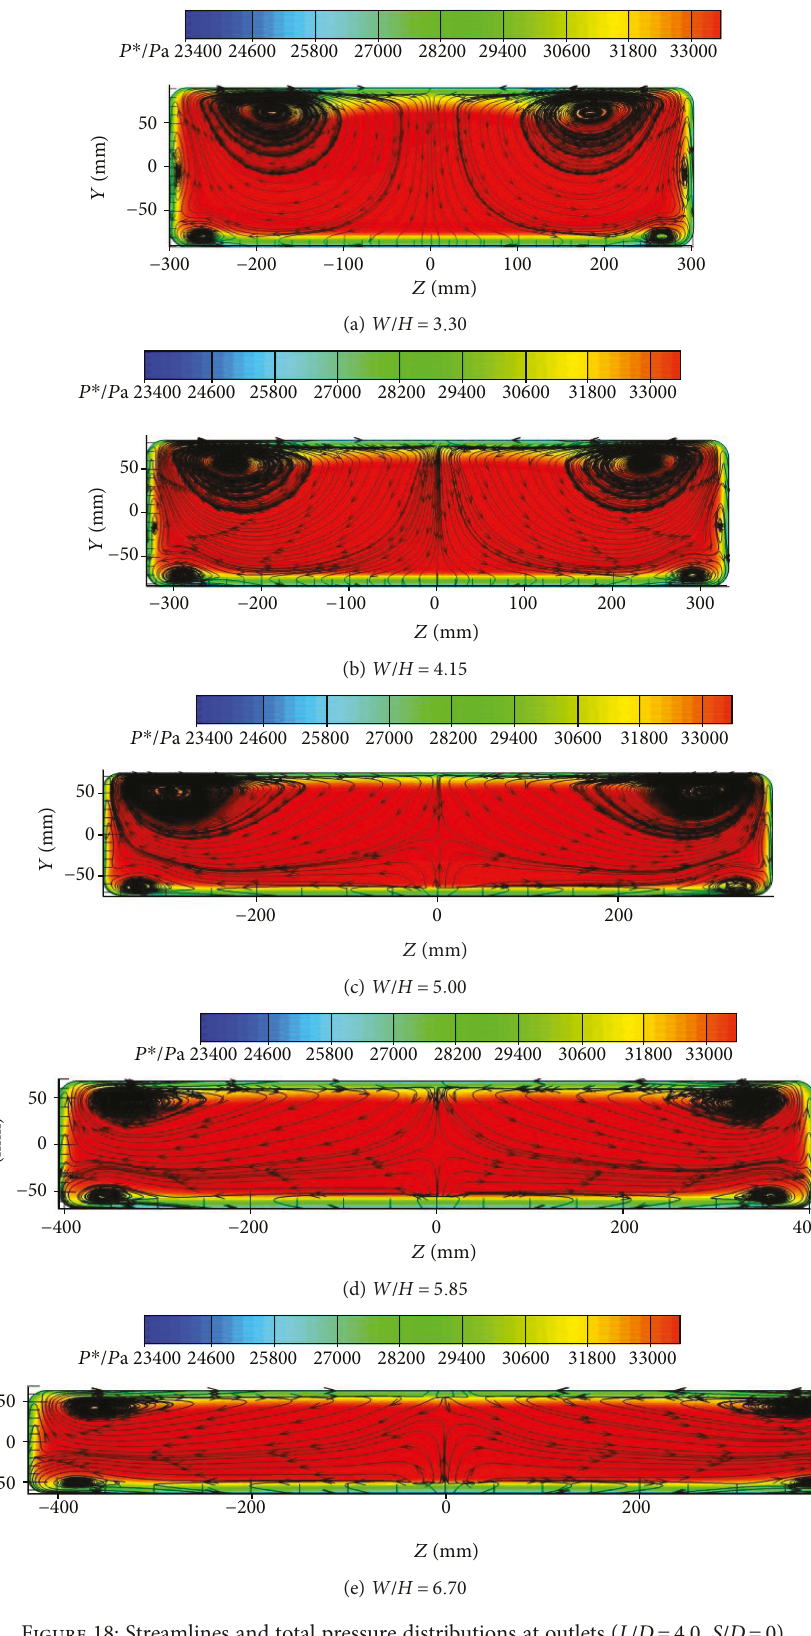
Figure 18: Streamlines and total pressure distributions at outlets ( L/D =4.0, S/D